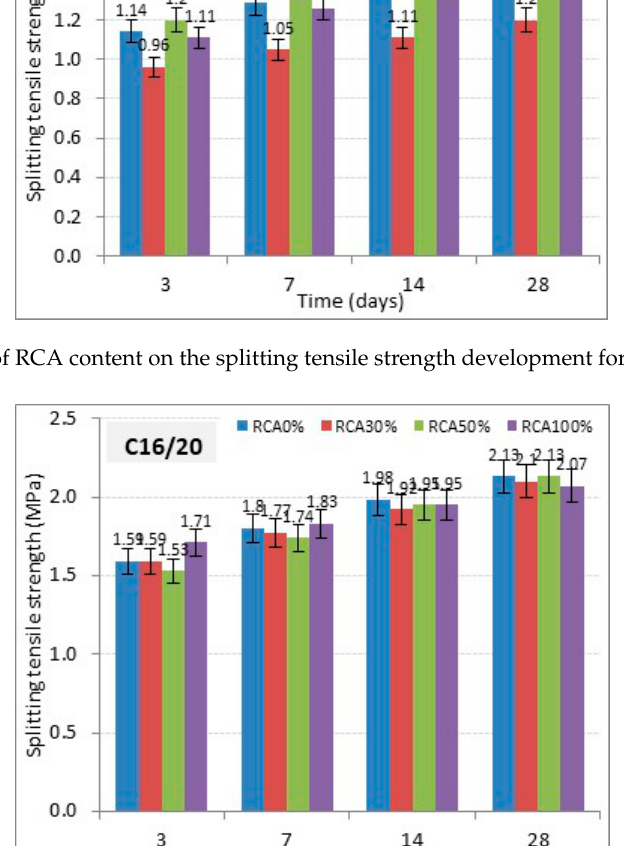
Figure 13. Effect of RCA content on the splitting tensile strength development for C25/30 concretes. 3.3. Durability Performances The durability of concrete produced using the RCA was examined in terms of porosity, resistance to carbonation, chloride ingress, and sulphate attack. The effect of partially or fully substituting NCA with the RCA was studied. 3.3.1. Porosity The ISA ‐ 10 test results of the control and RCA ‐ concretes designed with various RCA contents are presented in Figure 14. Embedding various amounts of RCA as part or even full substitution of NCA increased the ISA ‐ 10 as could be seen in Figure 10. The higher the substitution ratio of the RCA, the higher the ISA ‐ 10 of the concrete. The increase in ISA ‐ 10 was more noticeable for C12/15 as compared to C16/20 and C25/30. For the three grades of concrete investigated, using 30% RCA showed no significant increase in the ISA ‐ 10, while beyond this content, the ISA ‐ 10 increased rapidly. The increase in the ISA ‐ 10 of the RCA ‐ concrete is due to the highly porous and absorptive nature of the RCA used.